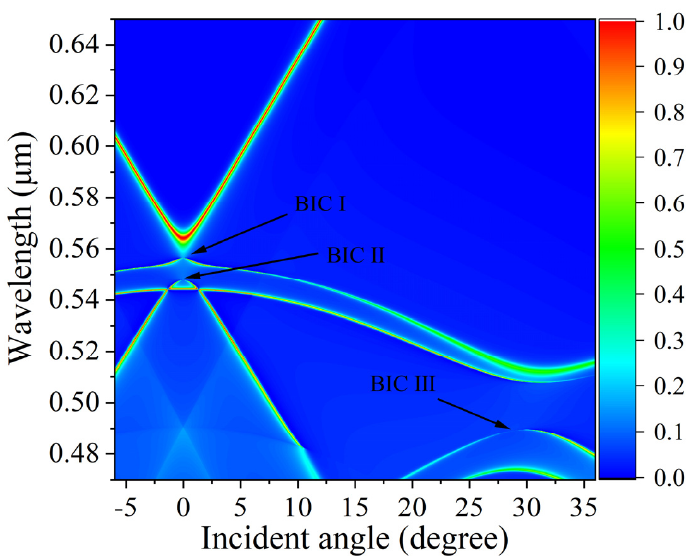
Figure 11. Reflectance spectra of the metasurface under s-polarized plane wave. a = 0.336 µ m, Figure 11. Re fl ectance spectra of the metasurface under s − polarized plane wave. a = 0.336 µm, L 1 = L 1 = L 2 = 0.2 µ m, W 1 = W 2 = 0.1 µ L 2 = 0.2 µm, W 1 = W 2 = 0.1 µm.